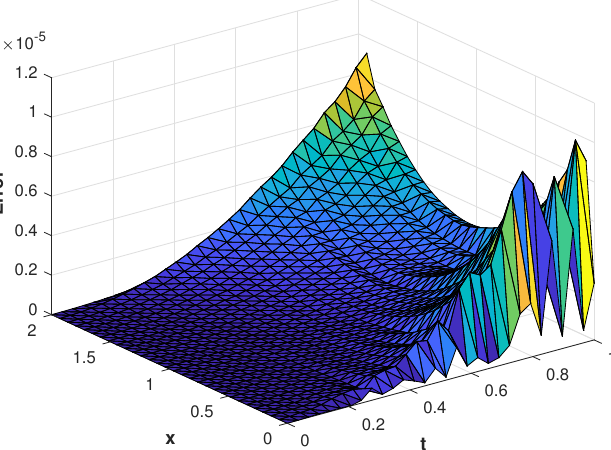
Figure 5: Rms Error of the proposed method with problem 1.